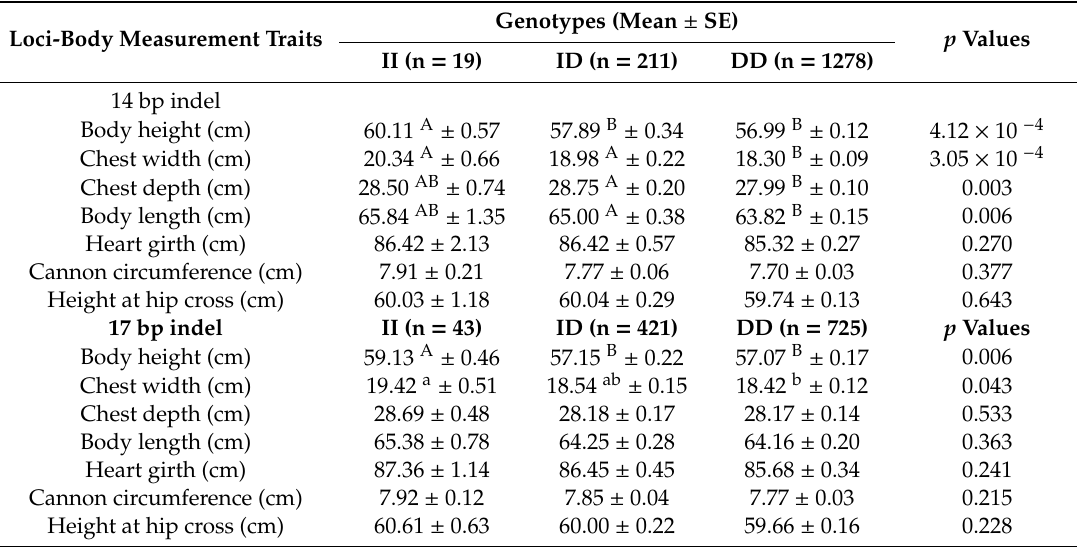
Table 3. The association of SPAG17 14 and 17 bp indels and body measurement traits of Shaanbei cashmere goats. Loci-Body Measurement